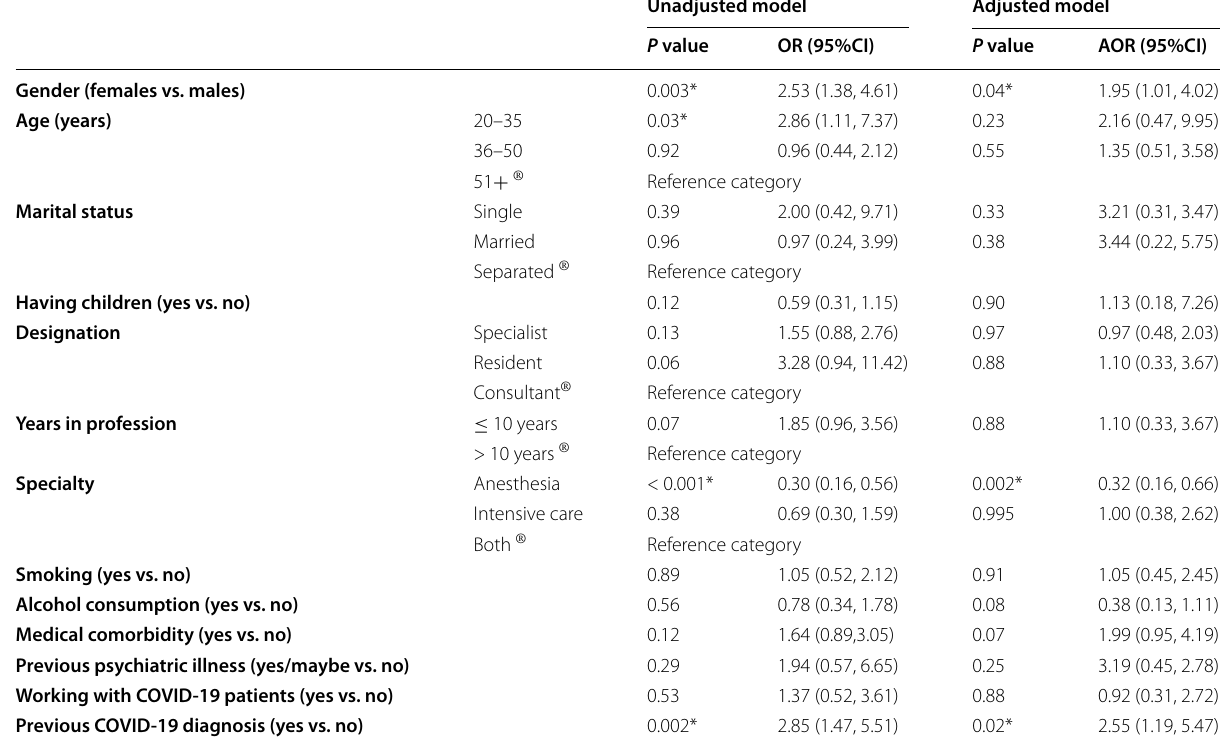
OR odds ratio, AOR adjusted odds ratio, CI confidence interval *Statistically significant at p <